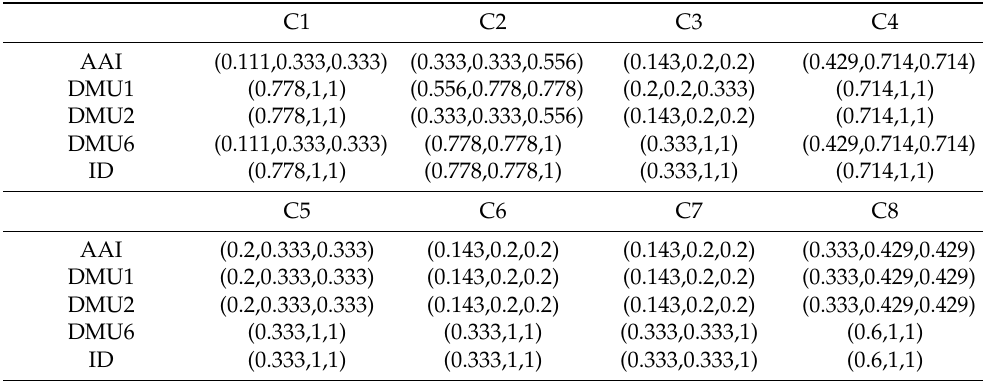
The next step involves performing the normalization of the matrix shown in Table 10, taking into account the type of criteria. Equation (16) is applied to the cost group of criteria (cid:16) (cid:17) 1.000 = ( 0.200, 0.200, 0.333 ) , while for the group of criteria as follows: (cid:101) n 13 = , 1.000 , 1.000 5.000 5.000 3.000 that prefer the maximum value, Equation (17) is applied: (cid:101) n 11 = ( 0.778, 1.000, 1.000 ) . The complete fuzzy normalized matrix is shown in Table 11. Table 11. Fuzzy normalized decision matrix.